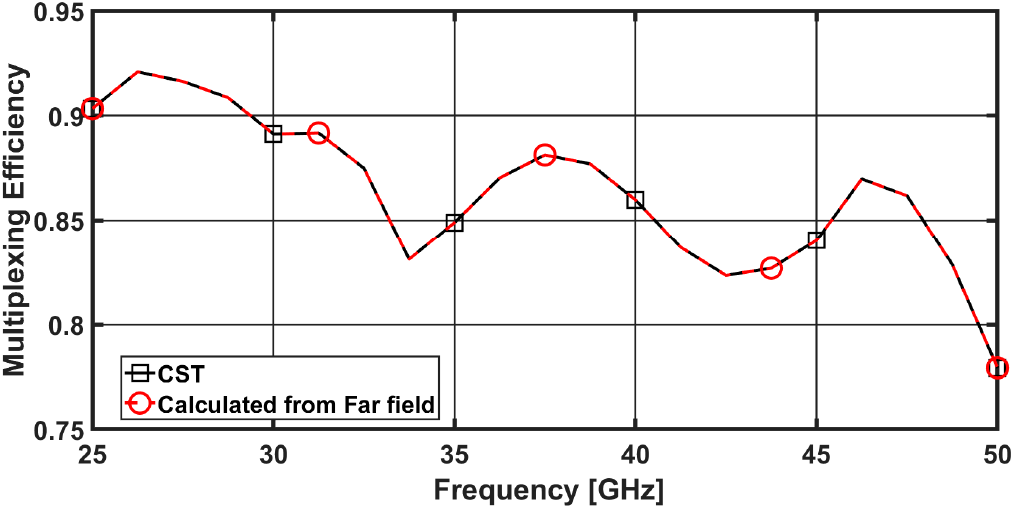
Figure 10. ME of the proposed four-element MIMO antenna between port 1 and 2.